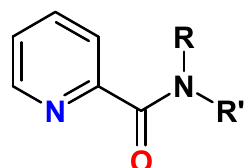
Figure 1. Amides of 2-pyridine-carboxylic acid (PA).